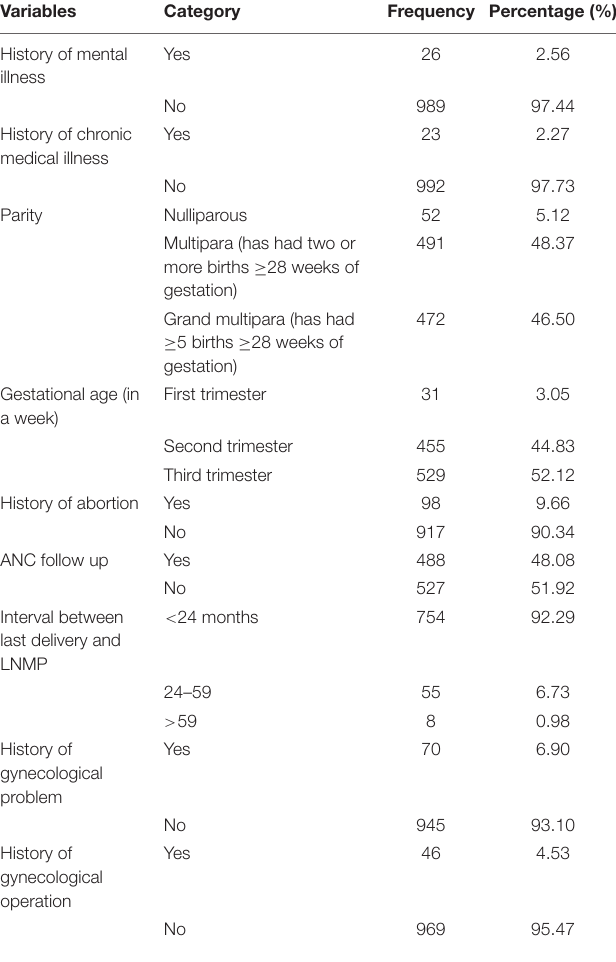
TABLE 2 | Medical, reproductive, obstetric, and gynecological characteristics of pregnant